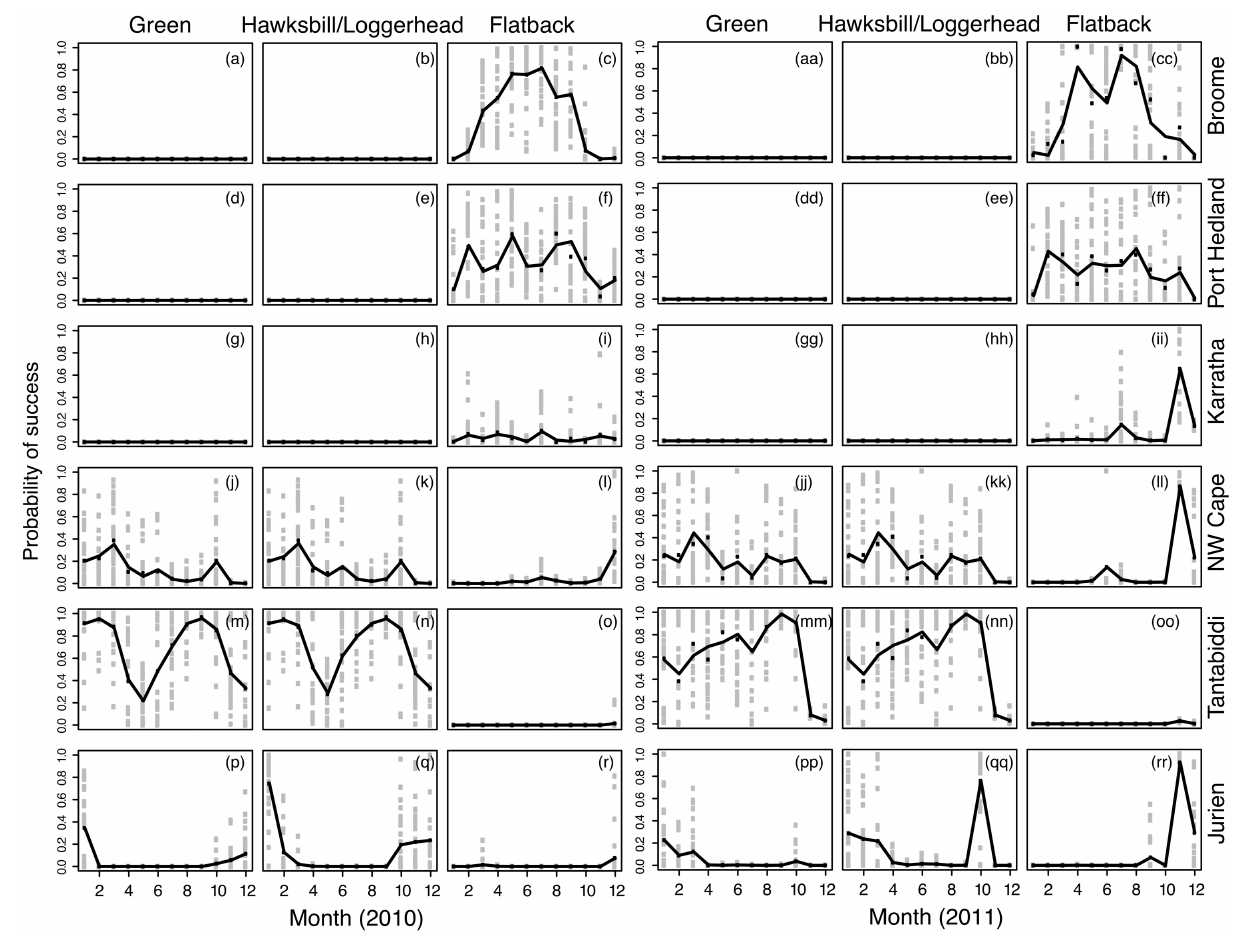
FIGURE 2 | Predicted probability of success (success of each particle is determined by the criteria: temperature, distance offshore, and beaching) from the model used to explain the relationship between particle success and month, site and year for each turtle species in 2010 (a-r) and 2011 (aa-rr). Plots for hawksbills and loggerheads are combined as they had alike results due the similar criteria used for success. Shown in black is the fitted line and gray points are average daily success and black points are mean monthly success.